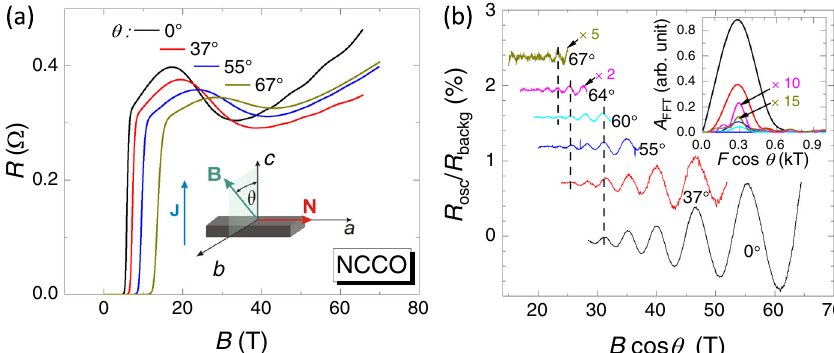
Fig. 4 Examples of magnetoresistance and angle-dependent SdH oscillations in optimally doped NCCO. a Examples of the B -dependent interlayer resistance at different fi eld orientations, at T = 2.5 K. Inset: the orientation of the current J and magnetic fi eld B relative to the crystal axes and the Néel axis N . b Oscillating component, normalized to the non-oscillating B -dependent resistance background, plotted as a function of the out-of-plane fi eld component B ? ¼ B cos θ . The curves corresponding to different tilt angles θ are vertically shifted for clarity. For θ = 64° and 67°, the ratio R osc / R backg is multiplied by a factor of 2 and 5, respectively. The vertical dashed lines are drawn to emphasize the constant oscillation phase in these coordinates; inset: FFT spectra of the SdH oscillations taken in the fi eld window [45 – 64] T.